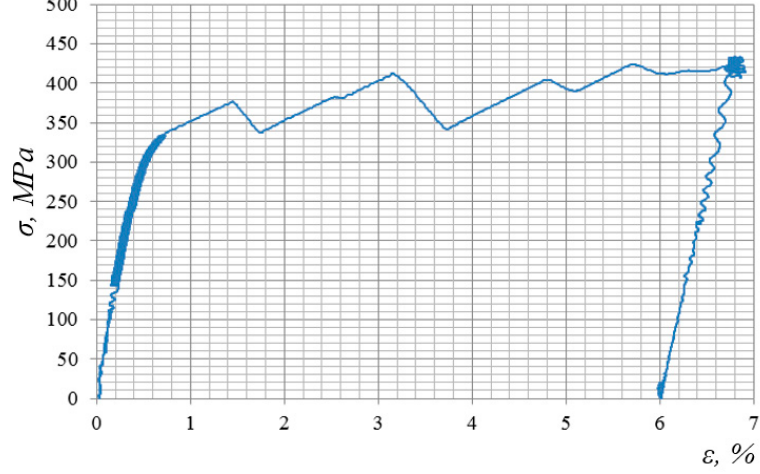
Figure 3. Stress-strain diagram of alloy 2024-T351 in the process of impulse introduction of force energy.